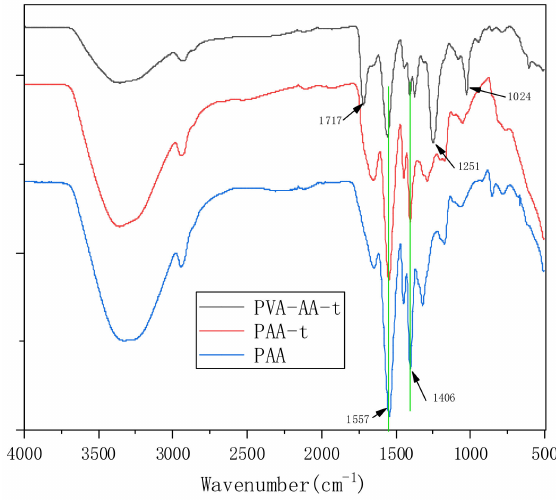
Figure 2. FTIR spectra of PVA-AA-t, PAA-t, and PAA